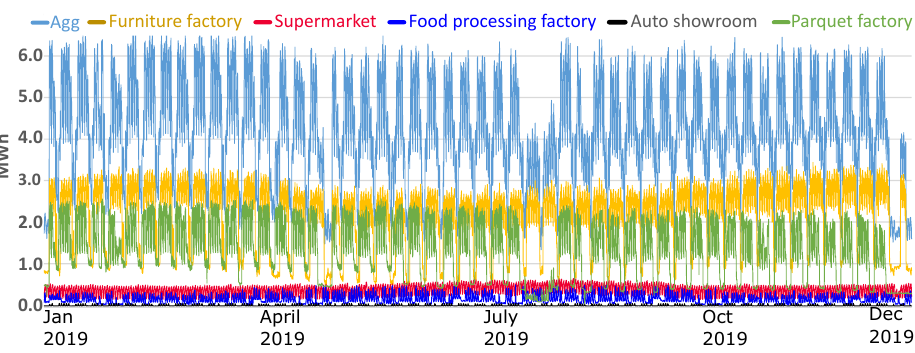
Figure 2. Load curves of industrial and commercial consumers. Agg: aggregate consumption. The structure of the cluster (2019 annual consumption). PF = parquet factory; FF = furniture factory; SM = supermarket; FPF = food processing factory; AS = auto